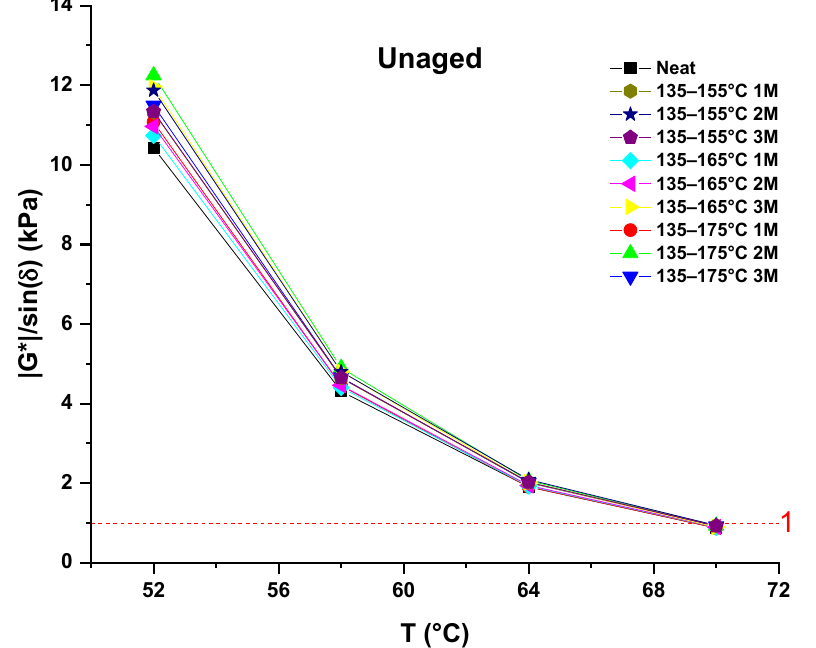
Figure 23. Rutting factor ( |G*|/sin(δ) ) at the unaged stage under different temperatures. In order to reduce rutting, the amount of work expended during each loading cycle should be kept to a minimum, which means that |G*|/sin(δ) should be maximized. This is why minimum values for |G*|/sin(δ) a re specified for unaged and RTFOT-aged binders in DSR analysis. For unaged binders, |G*|/sin(δ) should be ≥ 1.000 kPa. We can see from Figure 23 that all the samples attained the rutting factor (|G*|/sin(δ)) limit at the same temperature (69.3–69.7 °C). In addition, the differences between the samples’ rutting resistance factor values became smaller with the increase in the testing temperature. Figure 24. Rutting factor (|G* |/sin(δ) ) at the RTFOT-aged stage under different temperatures.